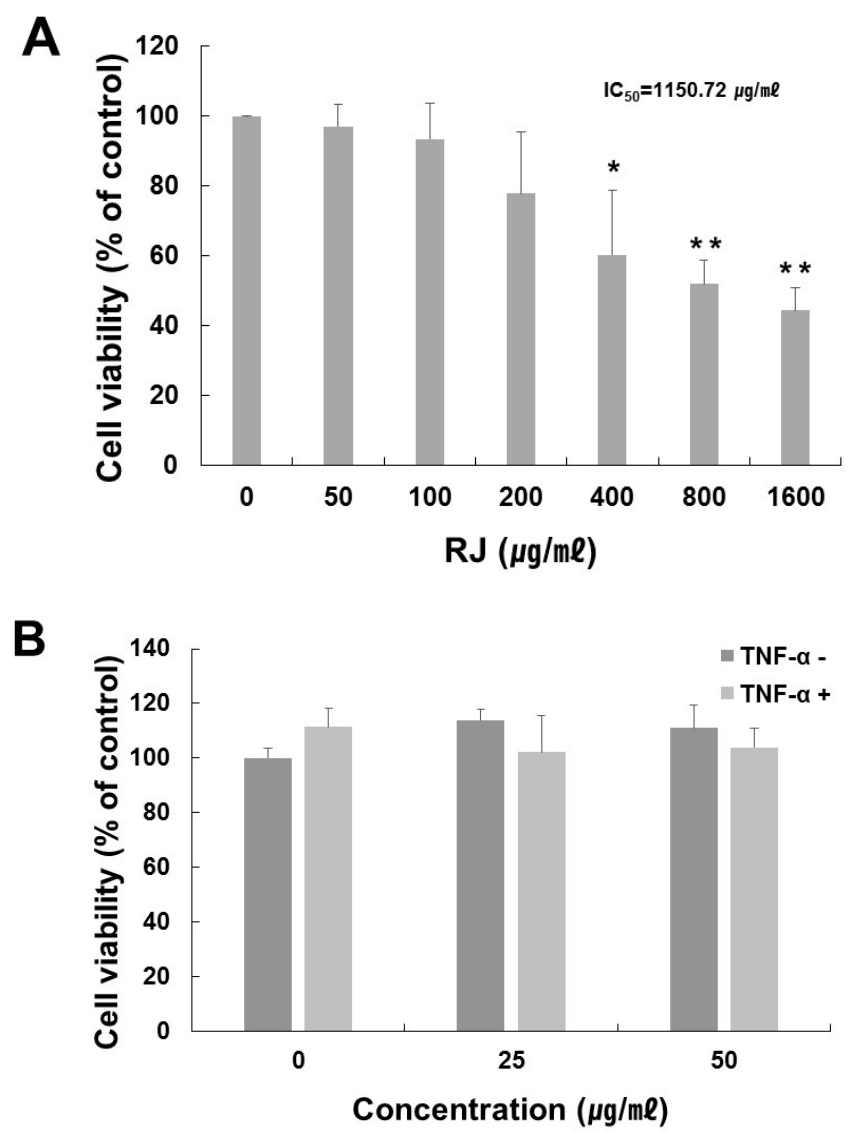
Figure 2. Cell viability of various treatment concentration of RJ on HaCaT cells. ( A ) HaCaT cells were treated with RJ at the indicated concentrations for 24 h. ( B ) Cell viability of RJ (0, 25, 50 µ g/mL) with or without TNF- α (10 ng/mL) in HaCaT cell. HaCaT cells were pretreated with 0, 25 and 50 µ g/mL RJ for 30 min then stimulated with 10 ng/mL of TNF- α for 30 min. Cell viability was then determined by MTT assay. The data shown are the mean ± SD of three independent experiments. Significant difference from control group, * p < 0.05, ** p < 0.01.